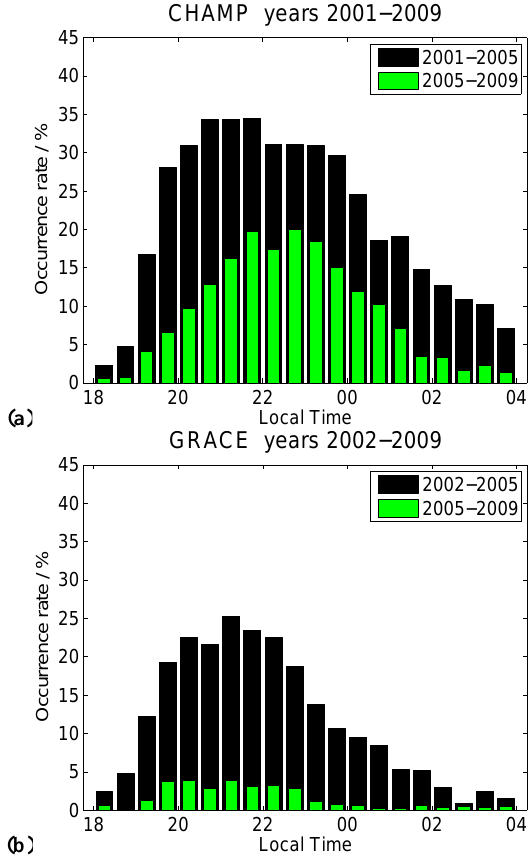
Fig. 8. Occurrence rate distribution of EPBs versus local time based on CHAMP PLP (top) and GRACE KBR (bottom) observation for the two solar activity